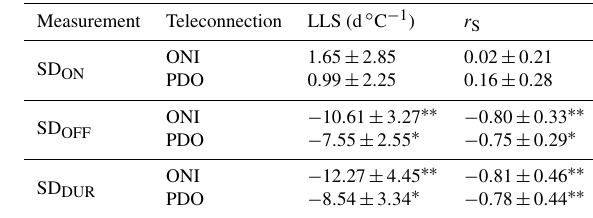
Significancelevel: ∗ p< 0 . 01 , ∗∗ p< 0 . 001